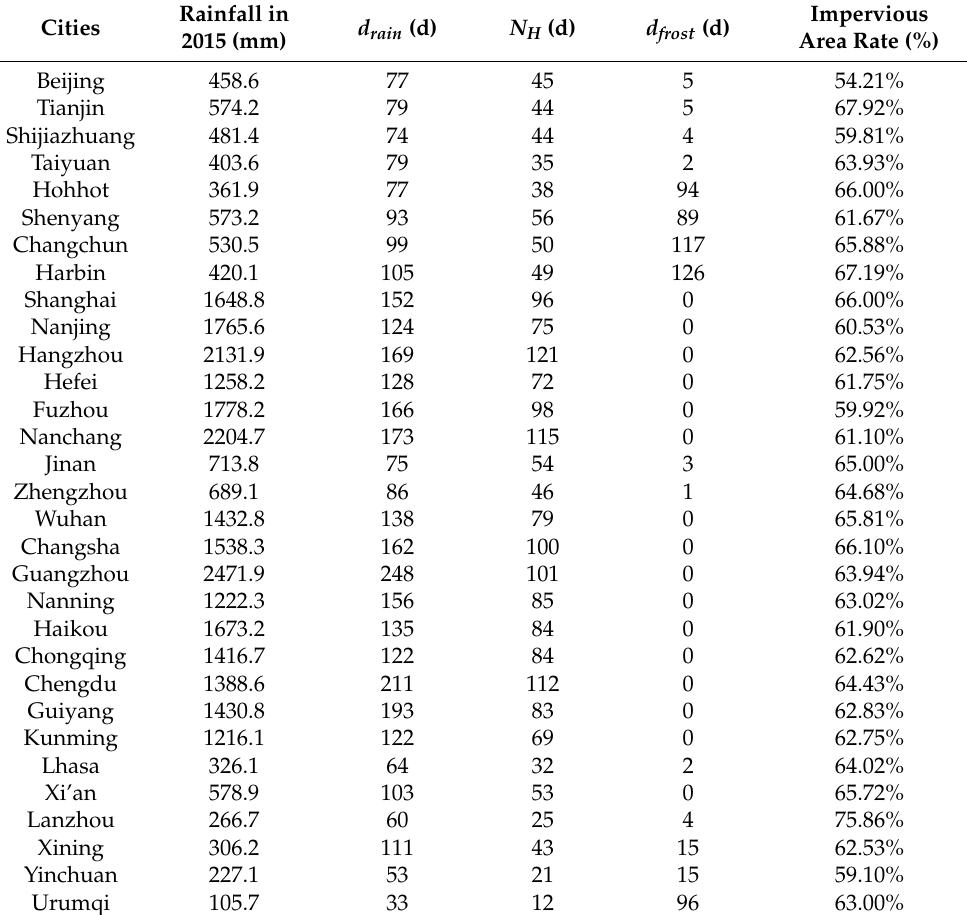
Table 1. Rainfall related data in 31 provincial capitals of China in